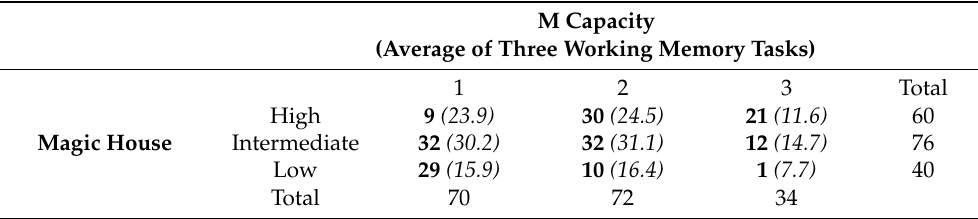
Table 3. Cross classification of Magic House performance by M capacity (observed frequencies in boldface; frequencies expected by chance in